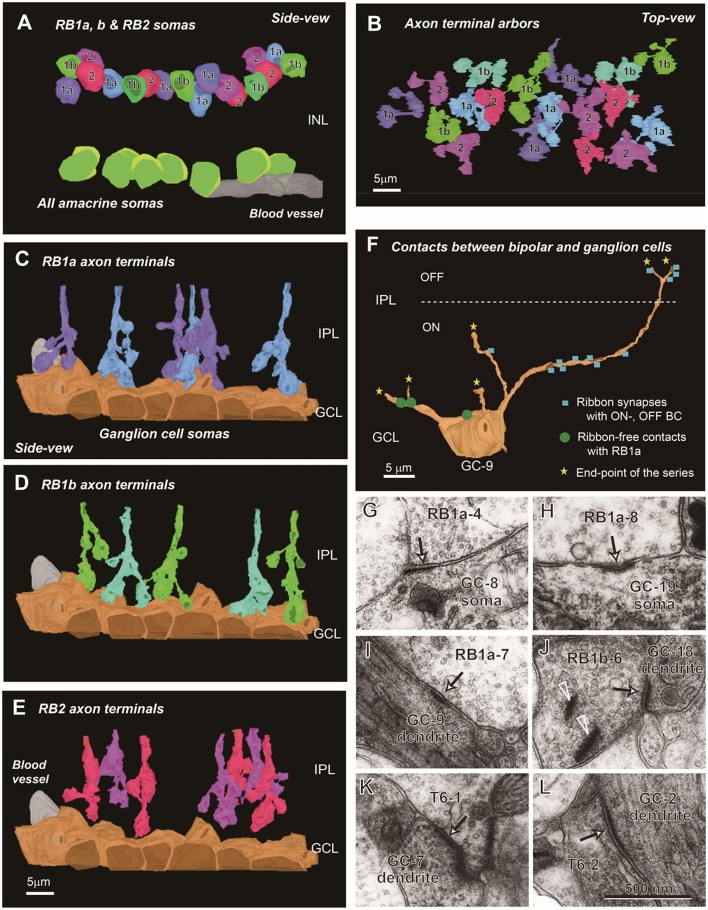
Spatial arrangement of RB1a, RB1b, and RB2 cells and fine structures of ribbon-free synapse-like contacts. (A) The somas of RB1a, RB1b, and RB2 cells are intermingled in the outermost sublayer of the INL. By contrast, the somas of AII amacrine cells are arrayed in the innermost sublayer of the INL. (B) The axon terminals of RB1a, RB1b, and RB2 cells are intermingled in the ON sublamina of the IPL. The somas (side view) and axon terminals (top view) of RB cells are not exactly in register because of the meandering courses of the axons. (C–E) The axon terminals of RB1a (C) and RB1b (D) cells extend downward and contact ganglion cell somas, whereas those of RB2 (E) cells are separate from ganglion cell somas. (F) The distribution of ribbon-associated synapses (blue squares) and ribbon-free synapse-like contacts (green discs) with a ganglion cell (GC-9: an ON-OFF type). The ganglion cell has ribbon-associated synapses with ON and OFF cone bipolar cells at the dendrites and ribbon-free synapse-like contacts with RB cells at the somas and dendrites. (G–L) Electron micrographs of ribbon-free synapse-like contacts (arrows) at bipolar cell axon terminals between RB cells and ganglion cell somas (G,H), between RB cells and ganglion cell dendrites (I,J), and between T6 cells and ganglion cell dendrites (K,L). In (J) there are synaptic ribbons (arrowheads) nearby but separate from the ribbon-free synapse-like contact.